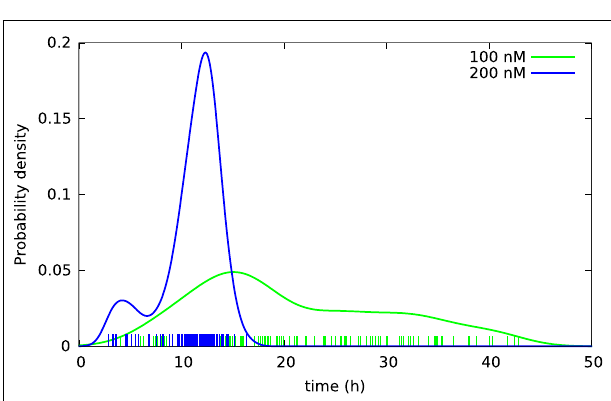
FIGURE 4 | Kernel density estimates of distributions of lifetimes of BC3H1 cells after YTX exposure at concentrations 100 and 200nM . Vertical bars indicate individual observations